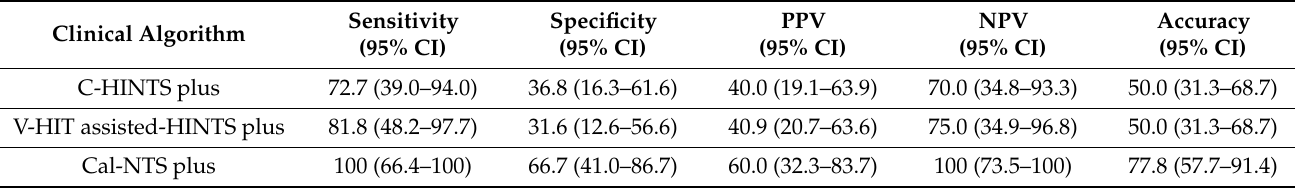
Table 2. Accuracy of the evaluated test